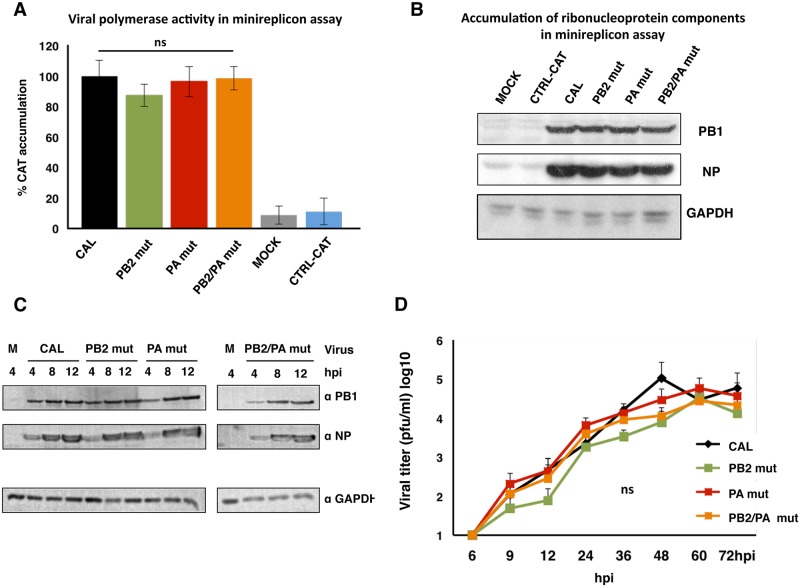
Recombinant viruses have comparable polymerase activity and replicate similarly in cell culture.(A) HEK293T cells were used for in vivo CAT RNP reconstitution (see Methods), which indicates viral polymerase activity. At 24 h post-reconstitution, CAT protein in total cell extract was analyzed by ELISA. MOCK, plasmids expressing PB1 or NP were omitted. CTRL-CAT indicates CAT accumulation in cells transfected exclusively with pHHNS-CAT plasmid. Three independent experiments were performed; values shown as means (%) ± SD. Significance was determined by two-way ANOVA with Bonferroni post hoc test (ns not significant). (B) Accumulation of PB1 and NP viral proteins was monitored in cell extracts used for CAT analysis, using GADPH as loading control. (C) Cultured A549 cells were infected at 3 pfu/cell with the recombinant viruses indicated in Table 1. At indicated hpi, samples were used to detect the indicated proteins by Western blot. Three independent experiments were performed and one of them is shown as representative. (D) Cultured A549 cells were infected at 10−3 pfu/cell with the recombinant viruses indicated in Table 1. At indicated hpi, supernatants were collected and virus titer determined by plaque assay in MDCK cells. Three independent experiments were performed in triplicate; values shown as means ± SD. Significance was determined by two-way ANOVA with Bonferroni post hoc test (ns not significant).